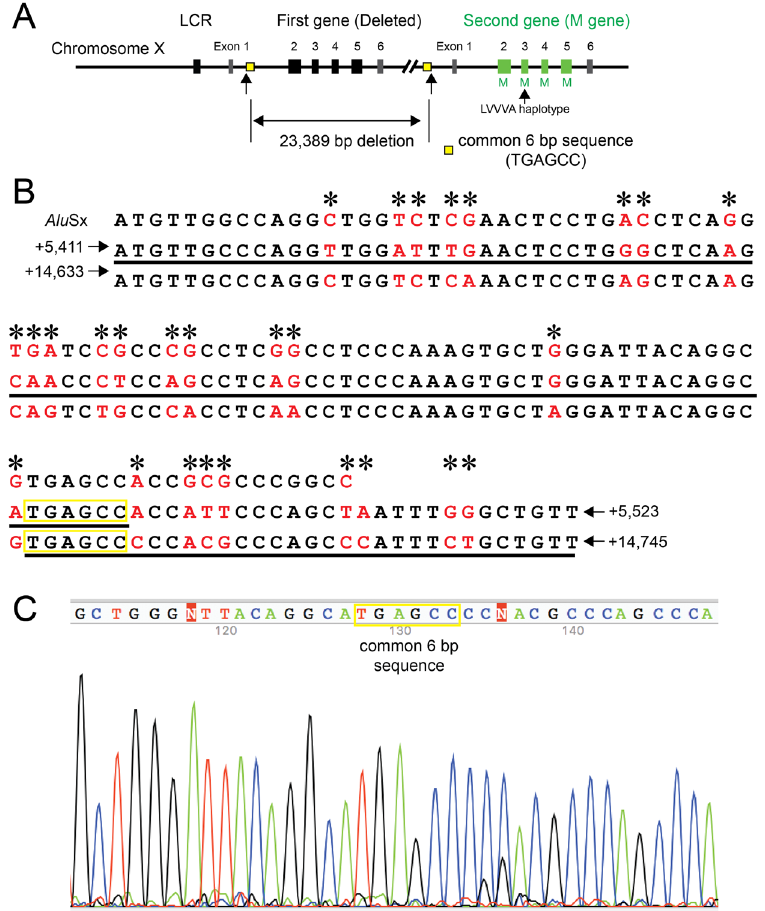
Figure 5. Genotype of Case 4. ( A ) Overview of the genotype of Case 4. Case 4 had a large deletion of 23,389 bp including exons 2–6 of the first gene. The intact LCR and second gene were present. The second gene had exons 2–5 of M type and exon 3 with LVVVA haplotype. ( B ) Upper row shows the consensus sequence for the left monomer of the Alu element (complementary sequence of AluSx). Middle row shows a part of intron 1 of the first gene (the number is from the 5 ′ splice site of intron 1). Lower row shows a part of the intergenic region (the number is from the stop codon in exon 6 of the first gene). The nucleotides differing among the regions are shown in red and by asterisks. The actual sequence obtained in Case 4 is underlined. ( C ) Partial sequence data around the breakpoint of the deletion. The breakpoint is somewhere in the common 6-bp